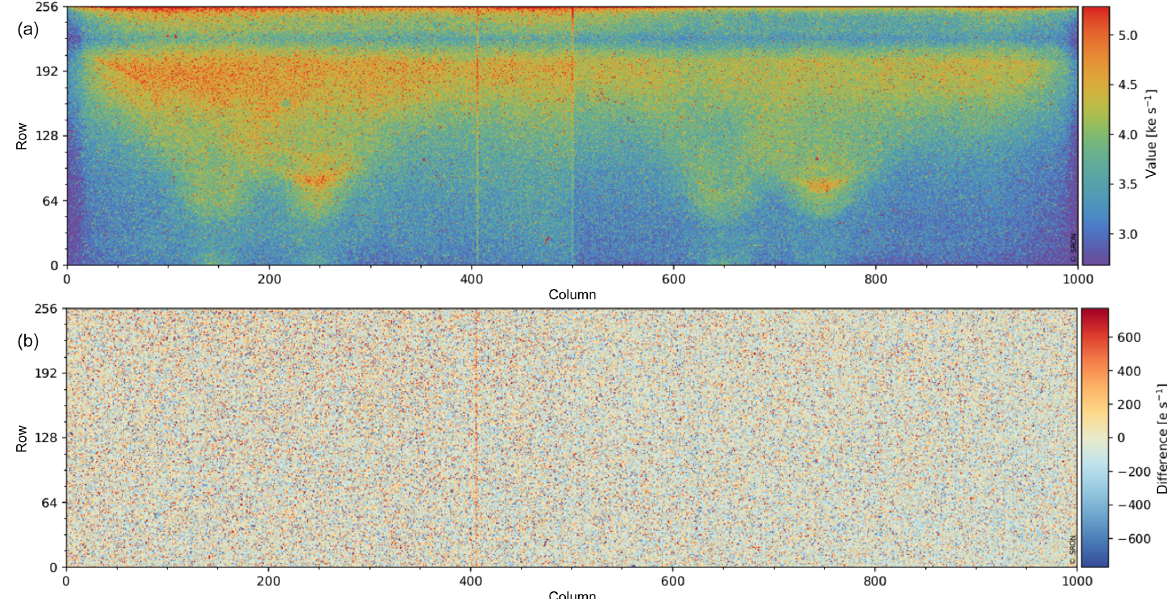
Figure 6. The typical dark current obtained with the FMM closed at the start of the nominal operations phase using data from orbits 2818 to 2833 can be seen in panel (a) . Data are plotted over the detector with the horizontal axis equivalent to the spectral direction and the vertical axis equivalent to the spatial swath. A comparisons to the dark current derived during the ground-based calibration is shown in panel (b) . Table 2. The median and spread of the various dark currents (nominal operations are with the FMM closed) and comparison with the median of the ground-based calibration. The difference is defined as the ground-based value minus the measurement. The ground-based results are based on many more measurements. As such, the uncertainties calculated from the spread are not comparable. Origin Orbit Median Spread Ground-based diff. (es − 1 ) (es − 1 ) (es − 1